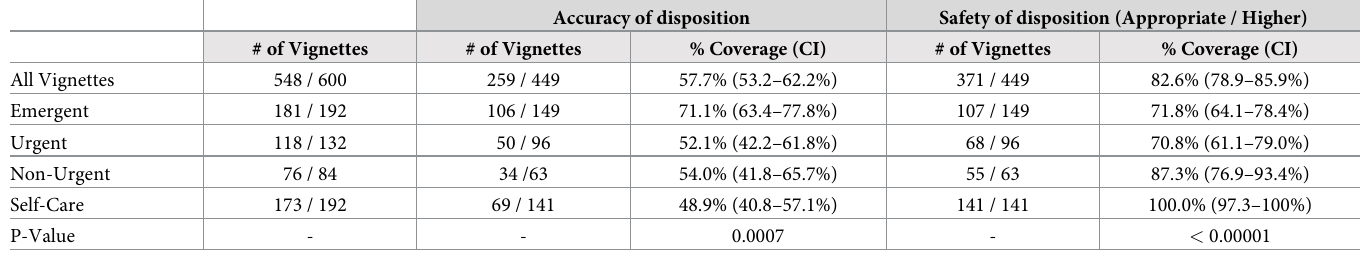
Table 3. Accuracy of triage capability and safety of the advised